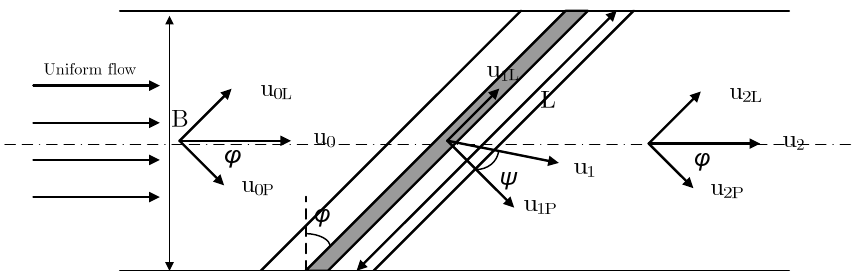
Fig. 4. Velocity decomposition upstream, at the crest and downstream of an oblique